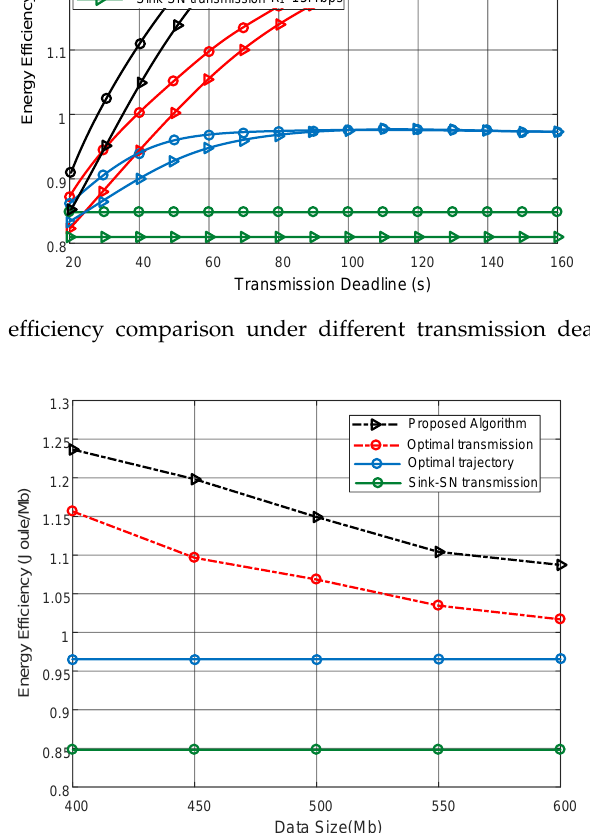
Figure 4. Energy efficiency comparison versus different data request within T = 80s, and R 1 = 20